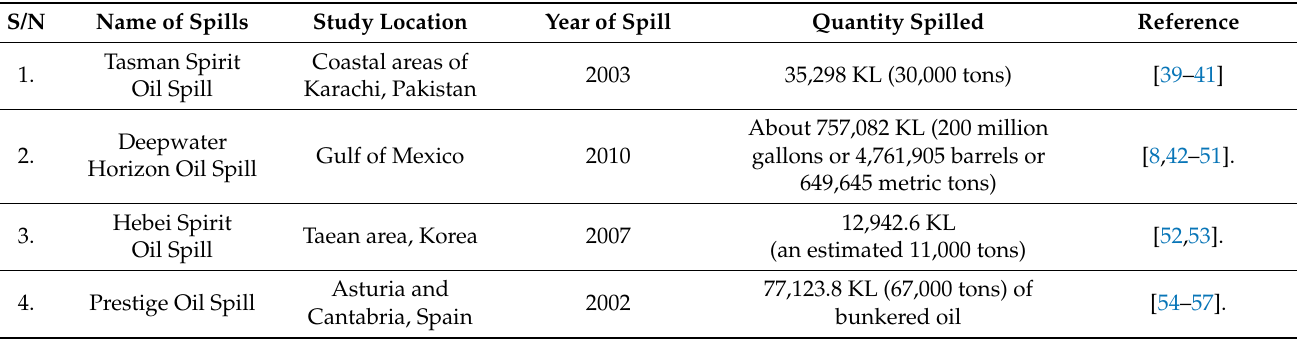
Table 1. Summary of crude oil spills captured in this